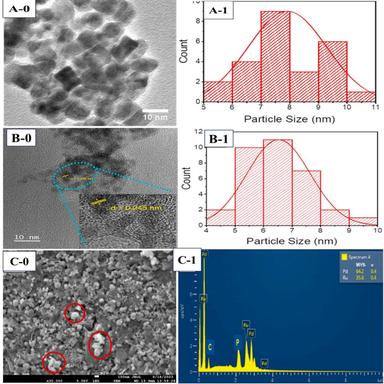
HRTEM micrographs of as-synthesized PdRu NPs (A) with an average size distribution of 7.79 nm ± 1.2 nm. High-resolution TEM of PdRu NPs (B-0), B-1 with an average size distribution of 6.54 nm ± 1.1 nm. SEM images of as-synthesized PdRu alloy nanoparticles (C-0) 100 nm (C-1) EDX.